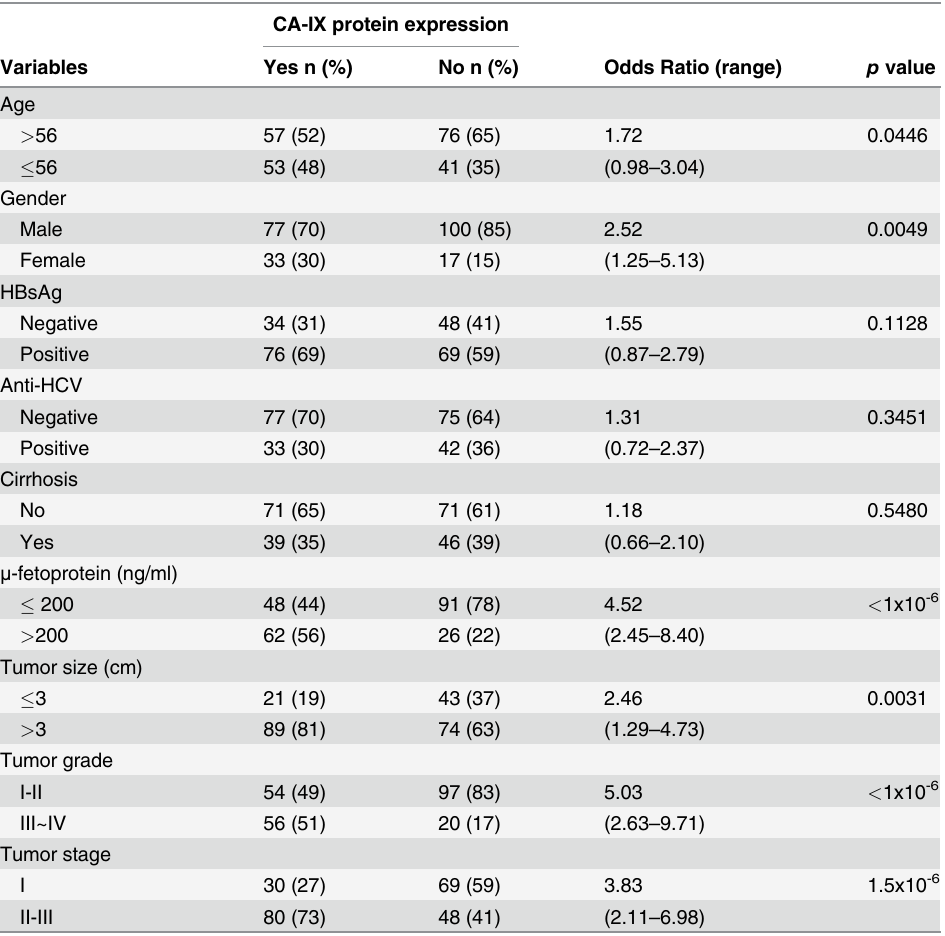
Table 1. Univariate analysis of CA-IX protein expression with various clinical and pathological features in 227 patients with surgically resectable primary hepatocellular